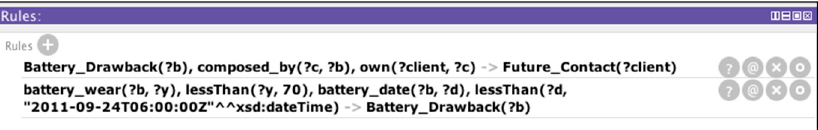
Figure 18. ‘Battery_Drawback’ inference example.